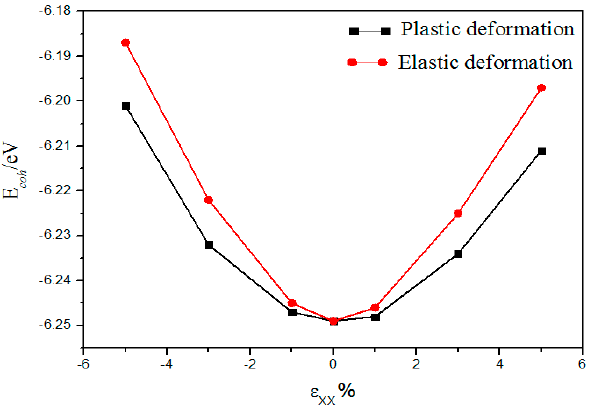
Figure 2. Cohesive energy E coh of In 0.5 Al 0.5 N after different deformations of biaxial strain.